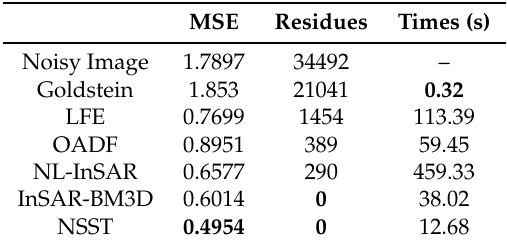
Table 4. Performance of various